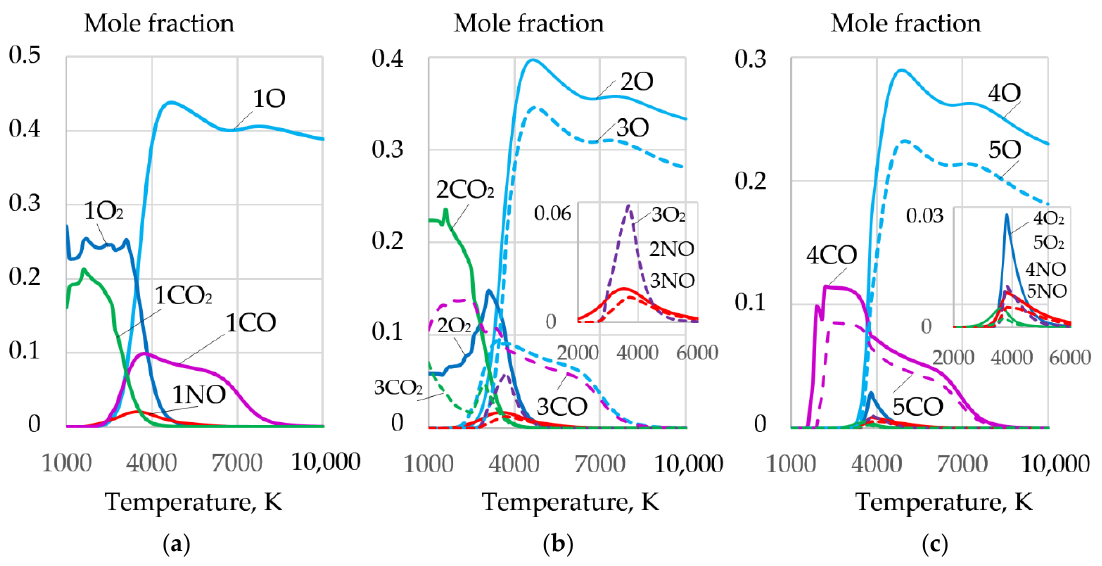
Figure 9. Mole fractions of gases in the system, wt.%: ( a ): ( 1 ) 40FeCO 3 + 40KNO 3 + 20Na 3 AlF 6 ; ( b ): ( 2 ) 35FeCO 3 + 35KNO 3 + 20Na 3 AlF 6 + 10Al; ( 3 ) 30FeCO 3 + 30KNO 3 + 20Na 3 AlF 6 + 20Al; ( c ): ( 4 ) 25FeCO 3 + 25KNO 3 + 20Na 3 AlF 6 + 30Al; ( 5 ) 20FeCO 3 + 20KNO 3 + 20Na 3 AlF 6 + 40Al.